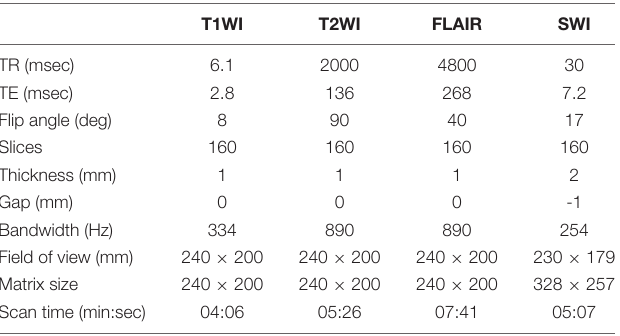
TABLE 1 | Detailed parameters of MR pulse sequence for three-dimensional stereotactic MRI for preoperative evaluation of deep brain stimulation surgery. T1WI T2WI